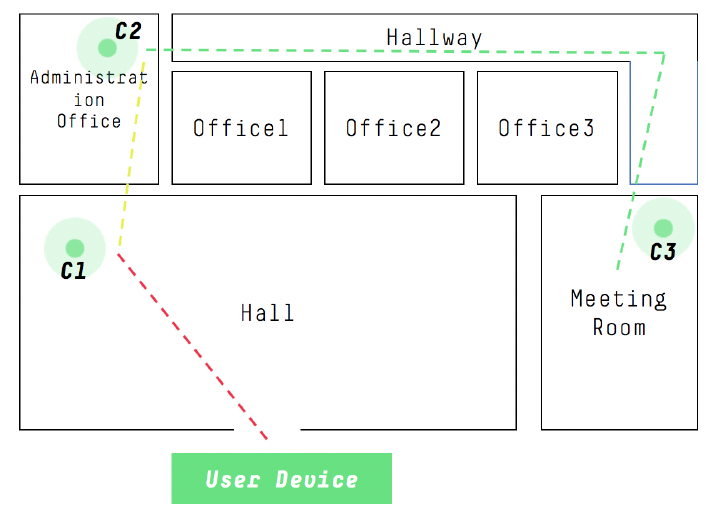
Figure 3. Example of a “Secure Path”: user passes through checkpoints C1, C2, and